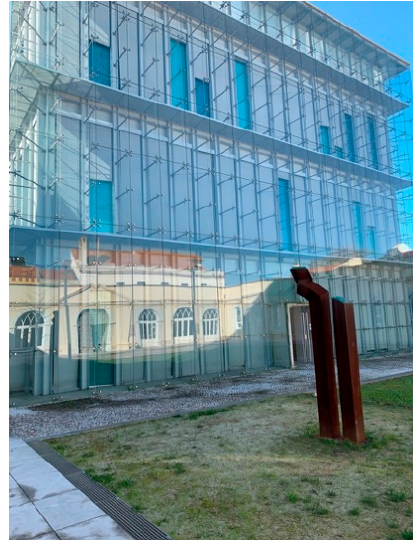
Figure 8. Portuguese Glass Museum (Contemporary Art). Photo credits: the author.